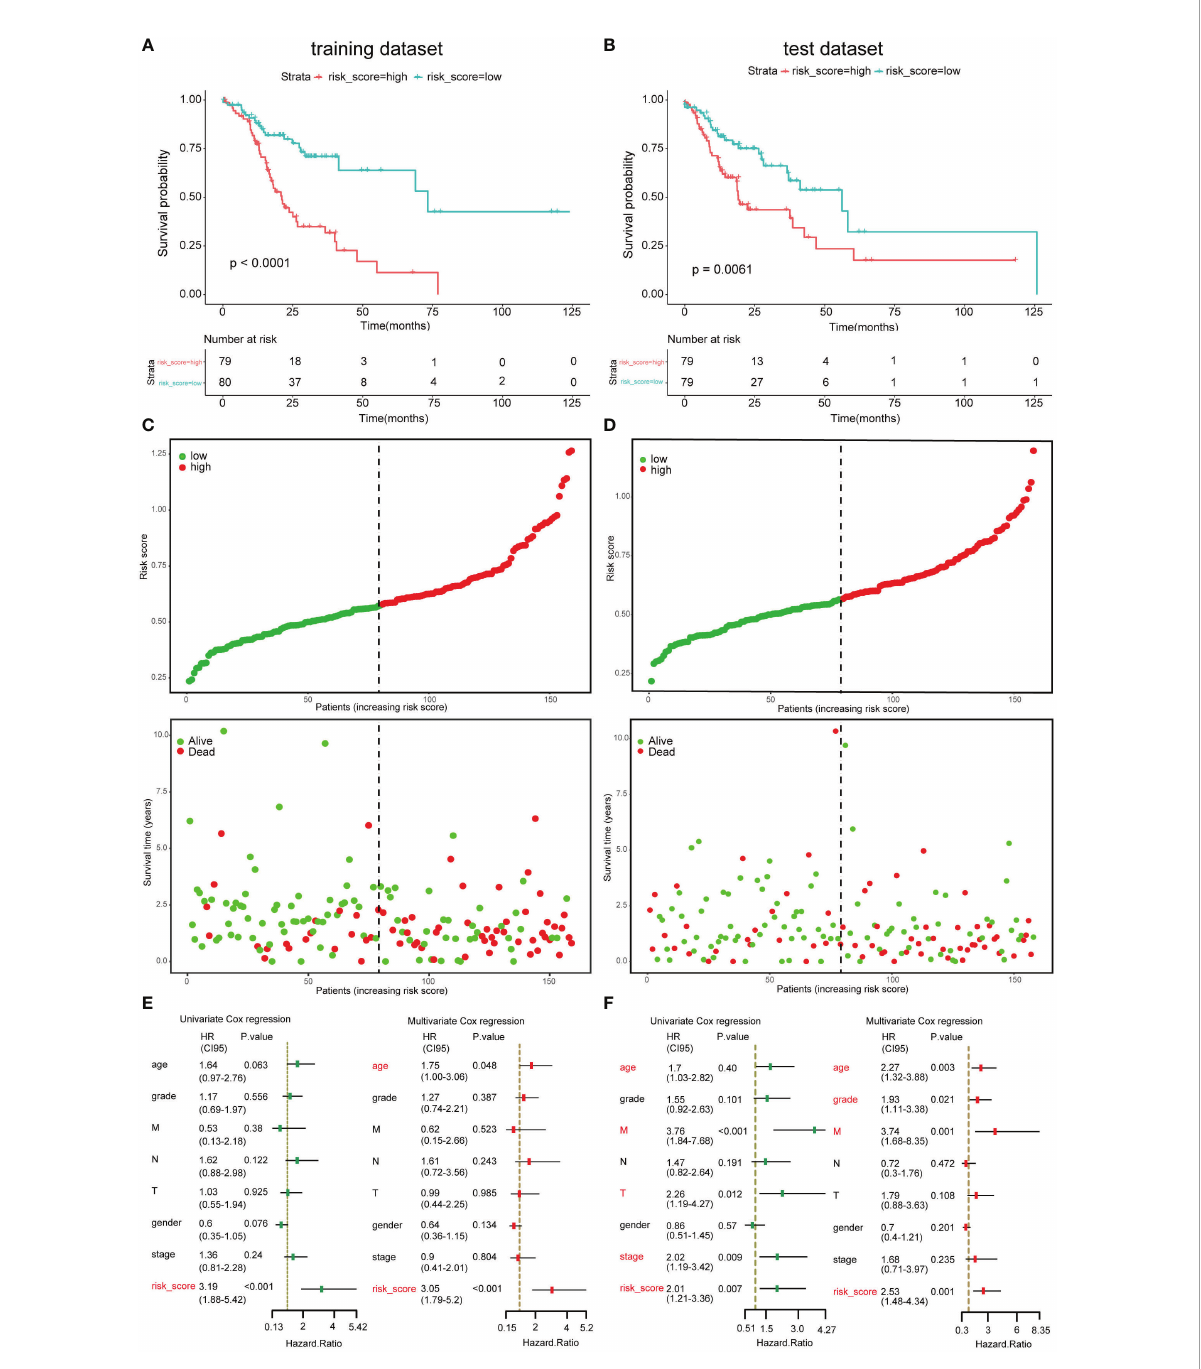
FIGURE 4 Validation of the risk model in the training dataset and test dataset. (A, B) Overall survival (OS) of the low-risk and high-risk subgroup in training dataset and test dataset. (C, D) The distribution of samples ’ survival time and vital status according to risk scores in the training dataset and test dataset. (E, F) Univariate Cox regression model and multivariate regression model with age, gender, stage, grade, T, N, M, and risk score in the training dataset and test dataset. Left, univariate Cox regression; right, multivariate Cox